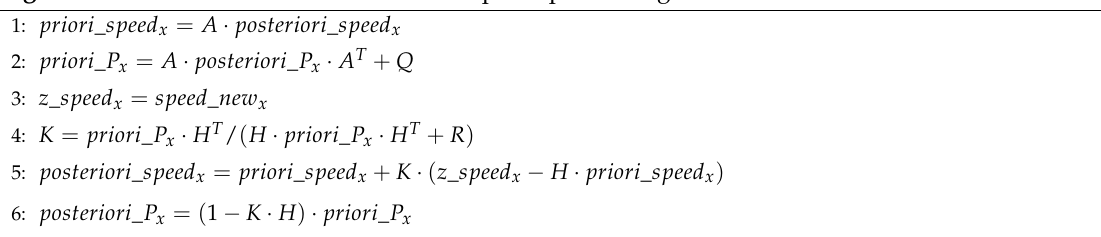
Algorithm 4, which computes the displacement on the x -axis, is similar to Algorithm 3.